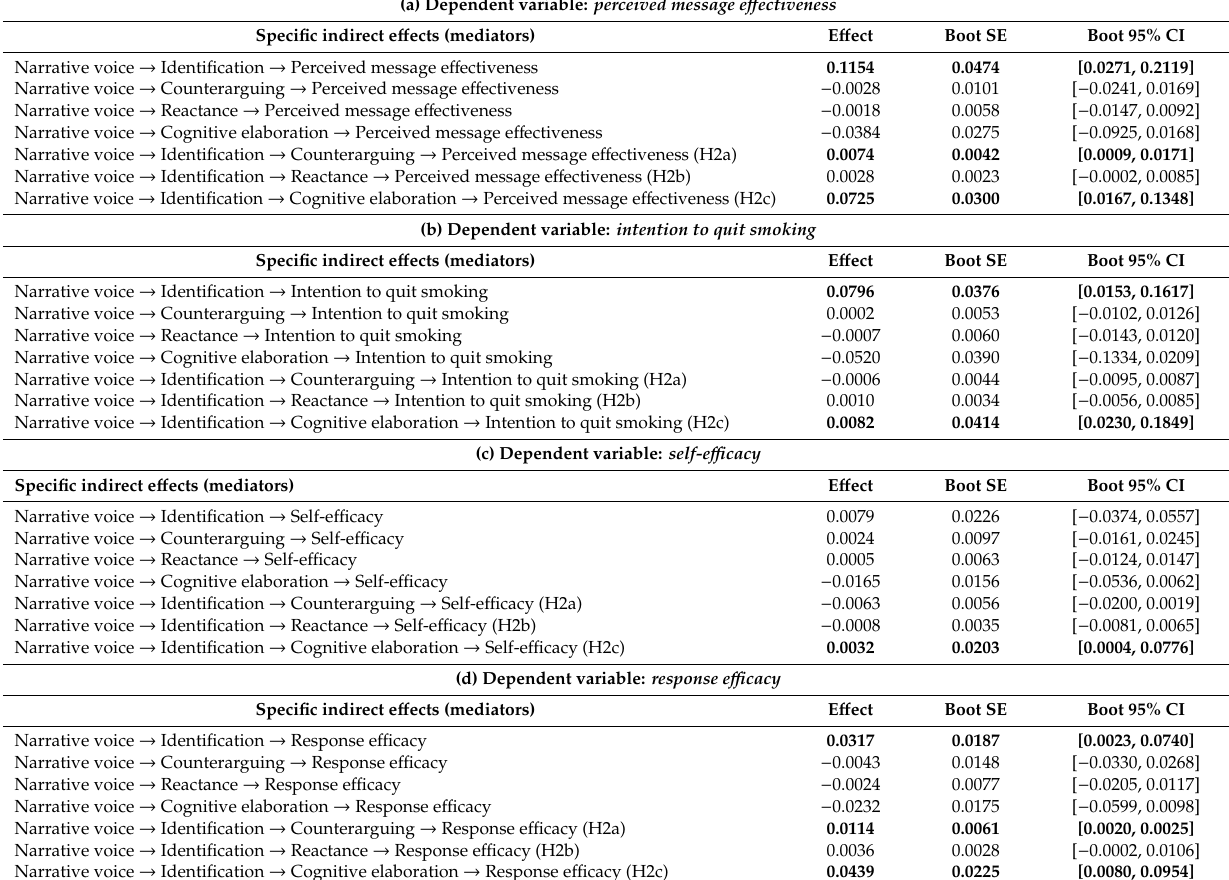
Table 4. Specific indirect e ff ects of narrative voice on perceived message e ff ectiveness, intention to quit smoking, self-e ffi cacy and response e ffi cacy through identification and cognitive processes (H2). Mediation models with